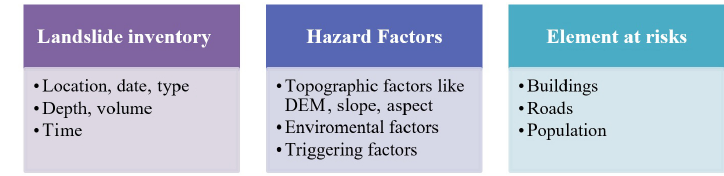
Figure 2. Database for landslide risk assessment and management (van Westen,